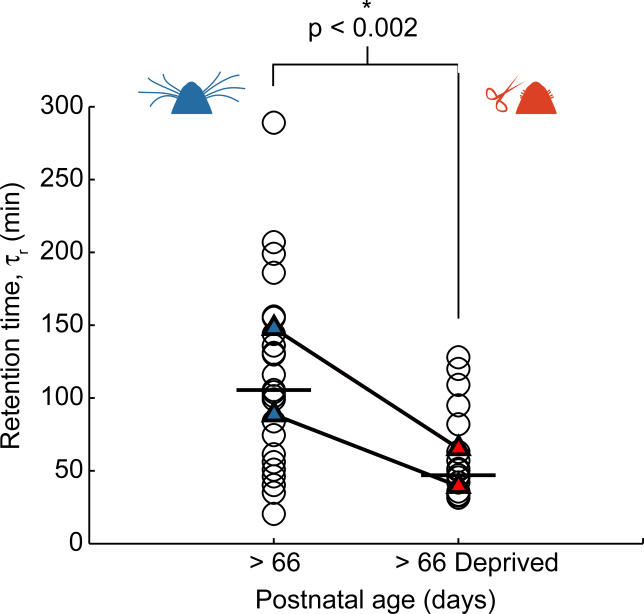
PSD-95 Retention Time Is Modulated by Sensory ExperienceCircles indicate individual spines (>P60 control data are repeated from Figure 2E). Horizontal bars indicate medians. Triangles indicate population averages for two animals in which retention times were measured before (blue) and after (red) whisker clipping.